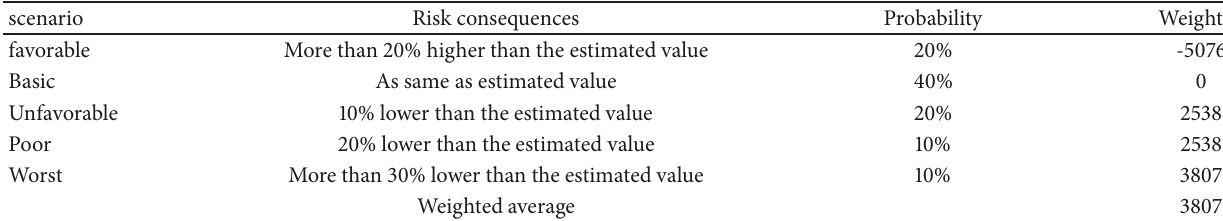
Table 7: The calculation process of PPP